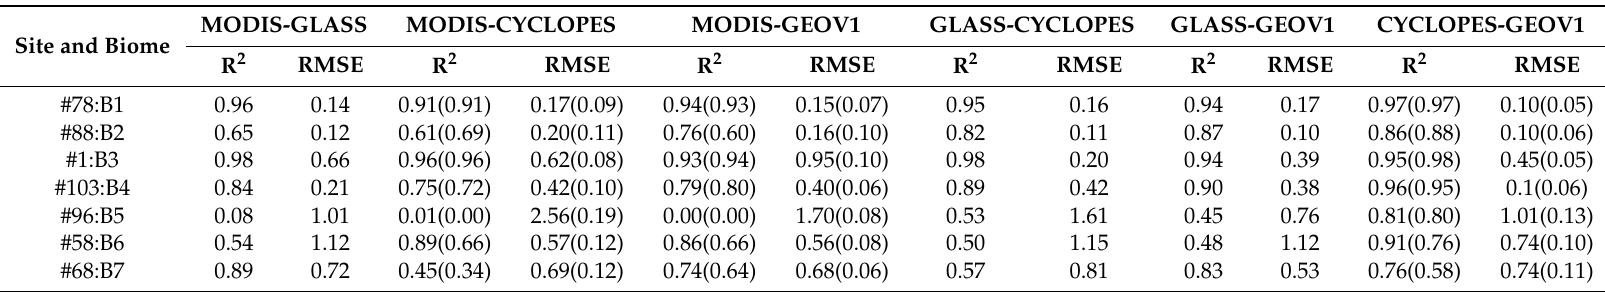
Table 5. Statistics of temporal comparisons among four LAI/FPAR products over seven validation sites during 2001–2004. R 2 and RMSE are provided. Values out of and in blankets are for LAI and FPAR,